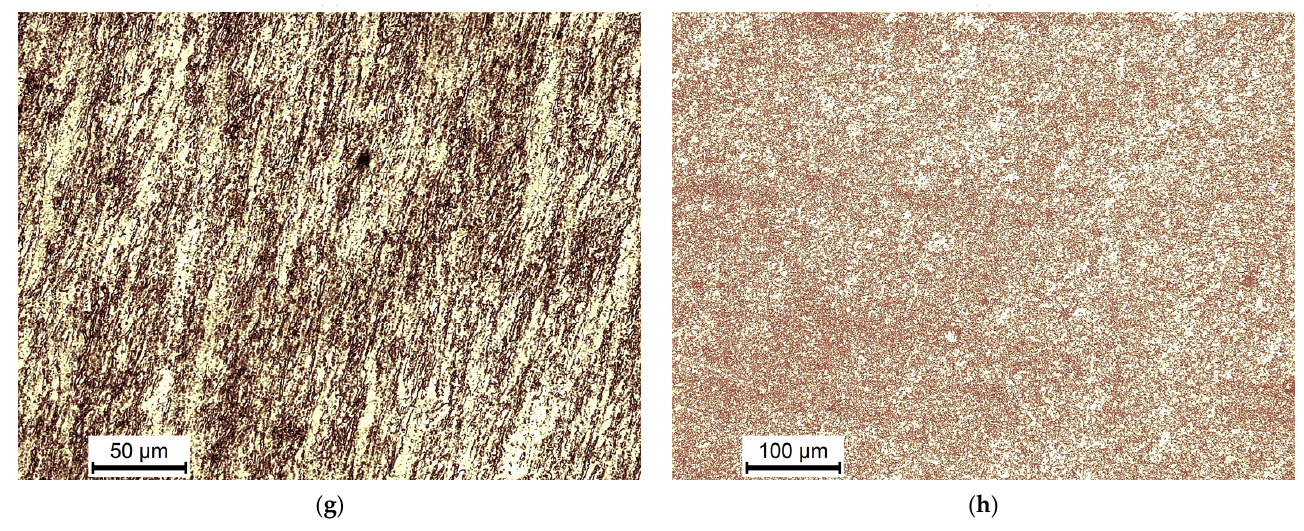
Figure 6. OM micrographs of the AA ( a ) Cu billets and ECAPEed billets processed through 2-Bc_90°die ( b ), 6-Bc_90°die ( c ), 6-A_90°die ( d ), 6-C_90°die ( e ), 6-Bc_90°die ( f ) 2-Bc_120°die ( g ) and 6-Bc_120°die ( h ) at RT ( b – e , g , h ) and at 200 °C ( f ).